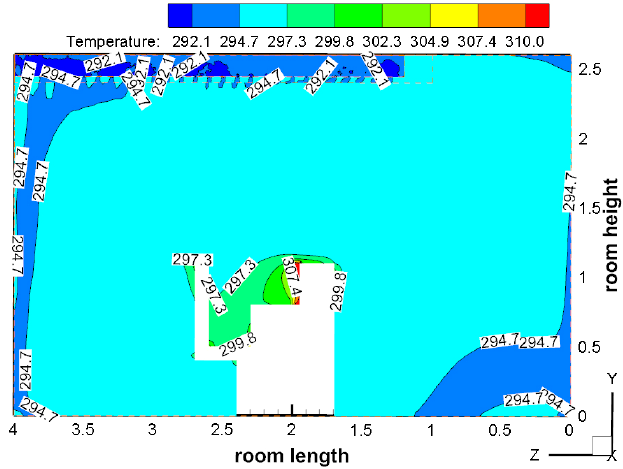
Figure 23. The temperature distribution of the Y = 0.6 m section.